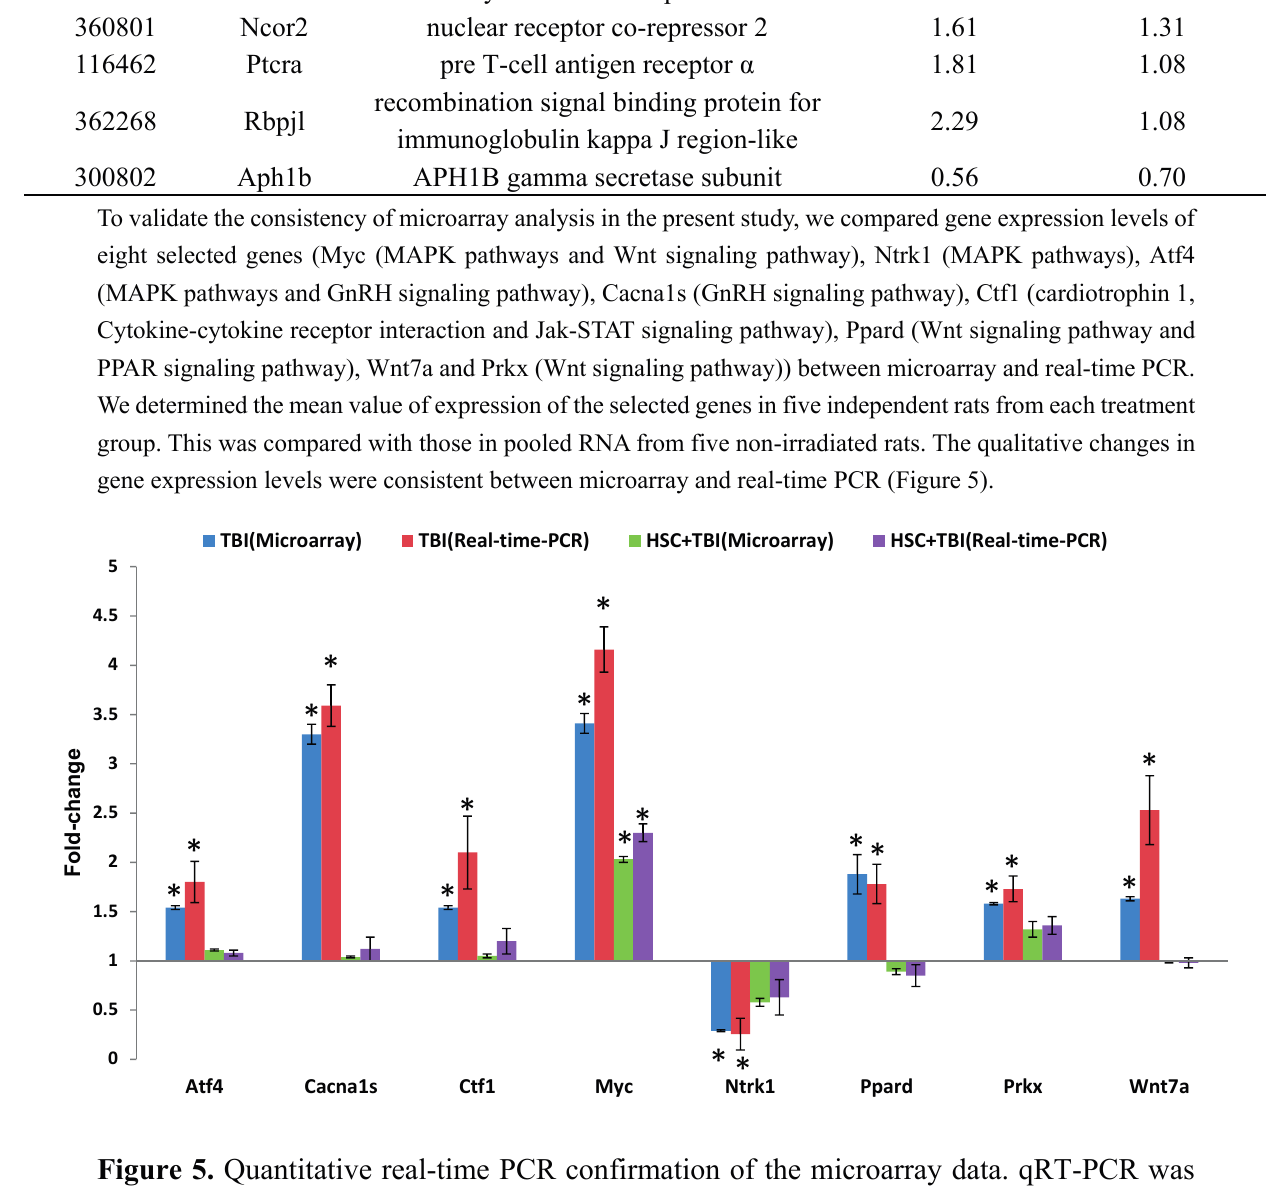
Table 6. The five genes that were involved in the Notch signaling pathway. Gene ID